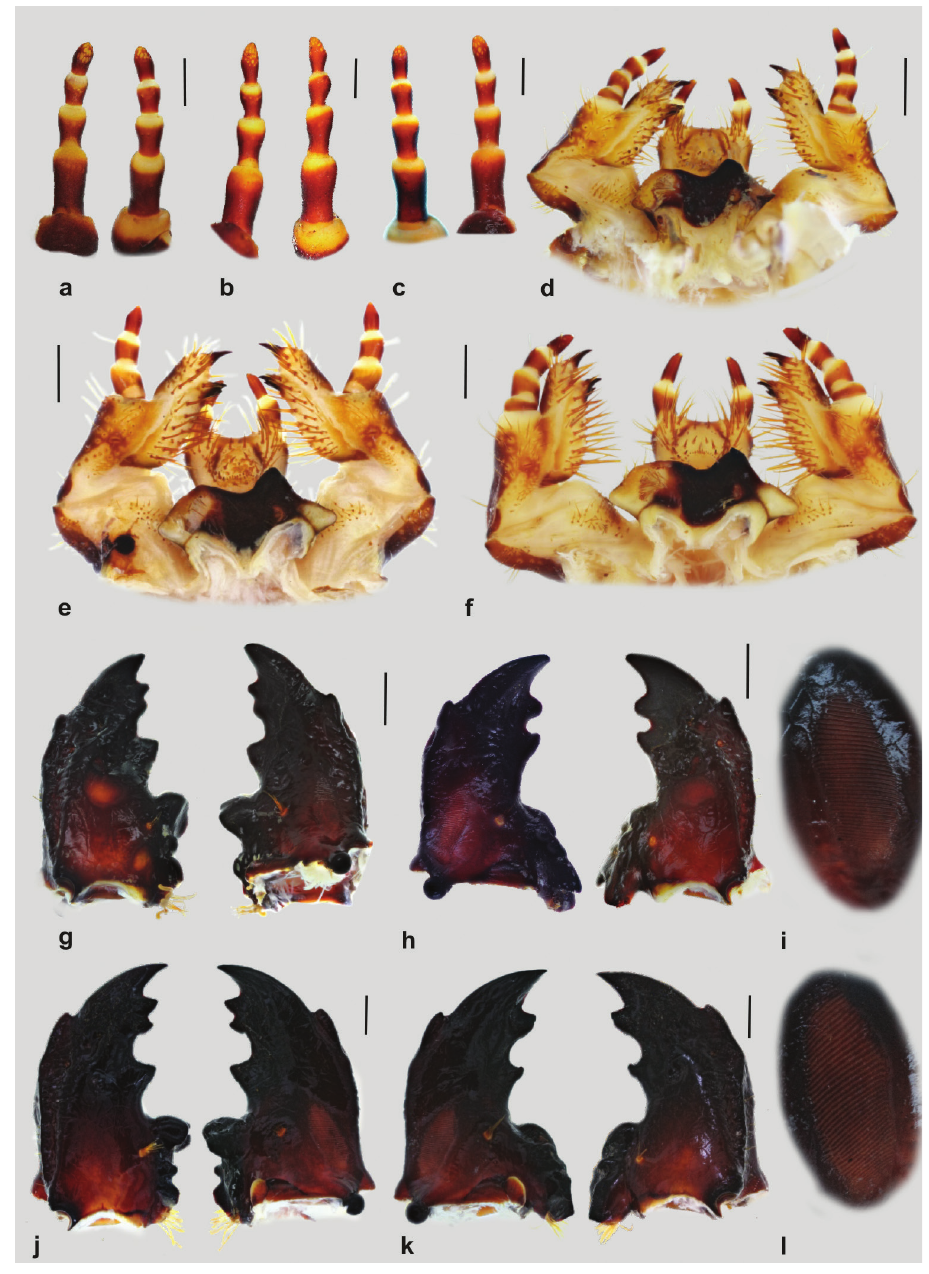
Figure 2 . Immature stages of the genus Goliathus : A–C right antenna, dorsal and ventral aspect ( A G. albosignatus B G. goliatu s C G. orientalis ) D–F maxillo-labial complex, dorsal aspect ( D G. albosignatus E G. goliatus F G. orientalis ) G–I G. albosignatus , mandibles ( G left mandible, dorsal and ventral aspects H right mandible, dorsal and ventral aspects I stridulatory area J–L G. goliatus , mandibles ( J left mandible, dorsal and ventral aspects K right mandible, dorsal and ventral aspects I stridulatory area. Scale bars: 1